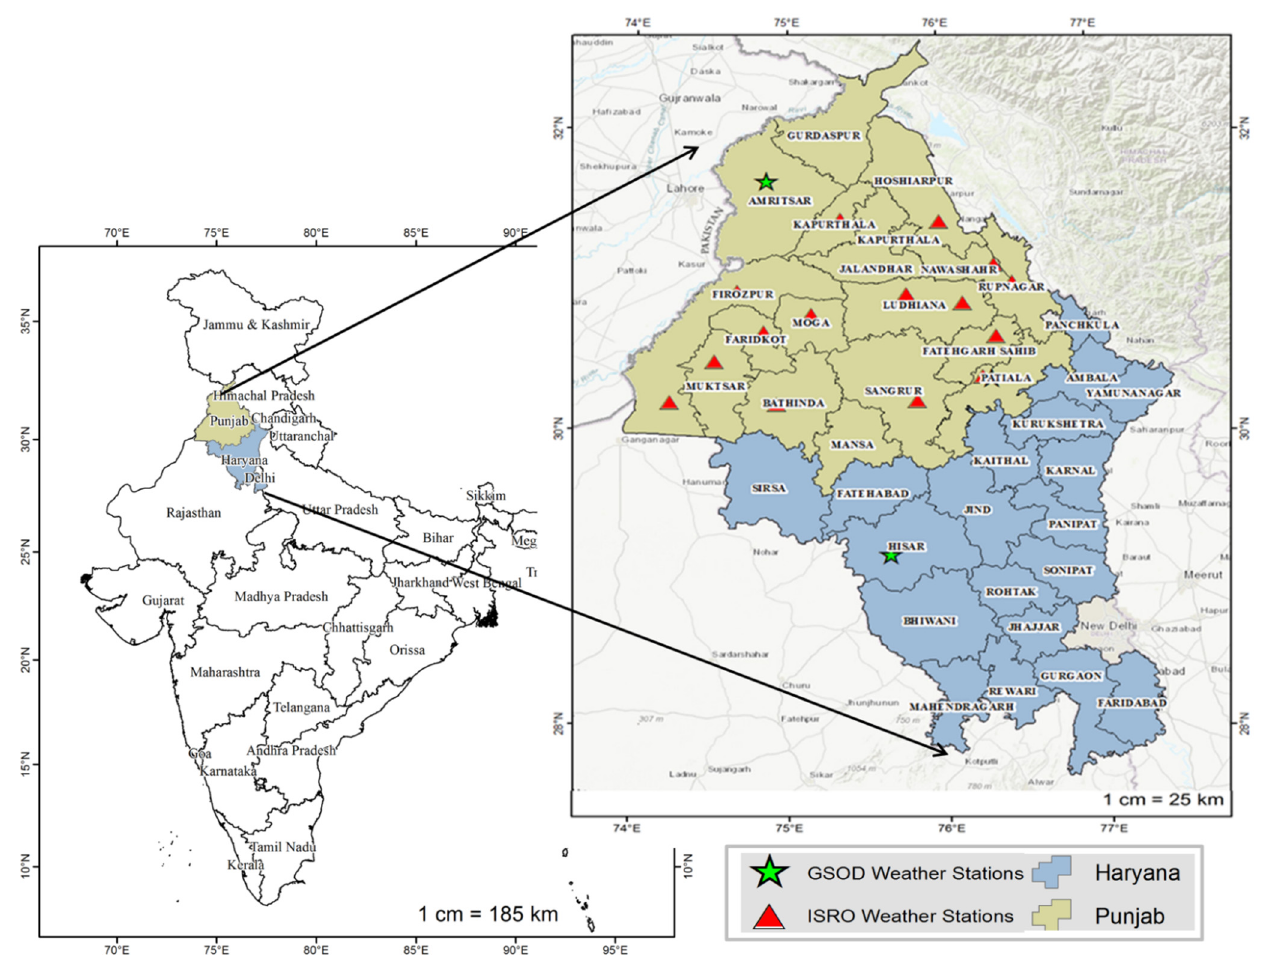
Figure 1. Study area—location map with meteorological station network. The model was initialized with Global Forecast System (GFS) forecast data, down- loaded at 0.5 degree resolution with 47 pressure levels. GWRF was set up with a global domain and two nests conforming to 1:5:5 ratios were implemented as two-way nesting. The model had 36 vertical levels with the top of the model atmosphere located at 10 hPa. The SST update was enabled in the parent domain to have a realistic pattern of the influ- ences of the ocean in the atmospheric modelling for extended simulations. The physics options and model configurations are listed in Table 1. The critical land surface parameters, such as topography, landuse/landcover (LULC) and leaf area index (LAI) were altered in the study based on results from Kirthiga and Patel